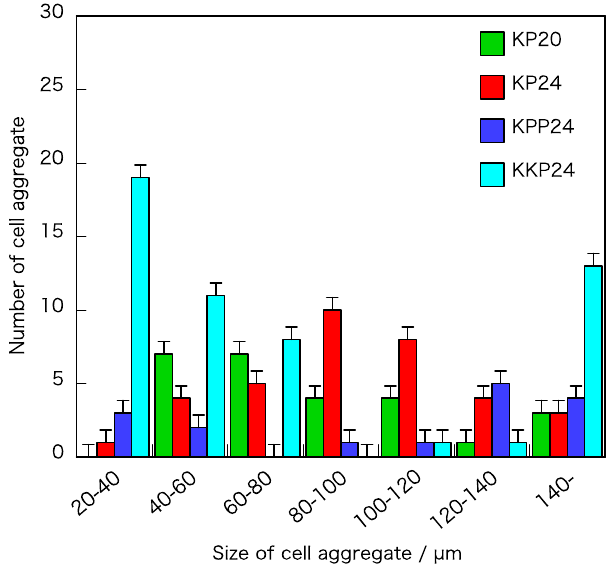
Figure 3. Distribution of cell aggregate size.